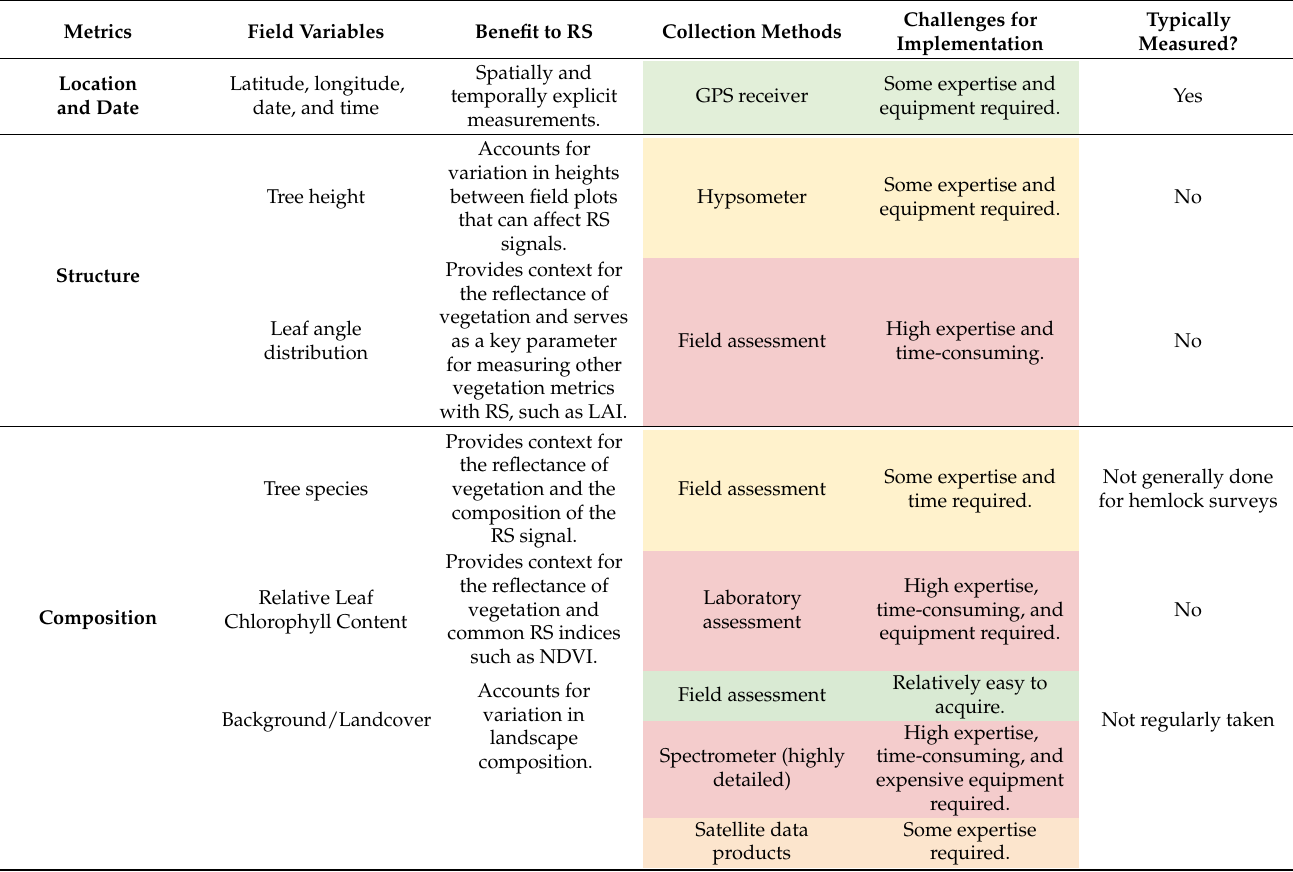
Table 1. A list of field variables that could facilitate collaborations between researchers and practitioners tackling complex problems like those posed by invasive species detection, monitoring, and management. Collection methods are color-coded based on the difficulty of the methods required for data collection and challenges for implementation (i.e.: green = easy, quick, and cheap; red = requires expertise, lengthy, expensive). The color scale is: green < yellow < orange < red, in order of least to most challenging to